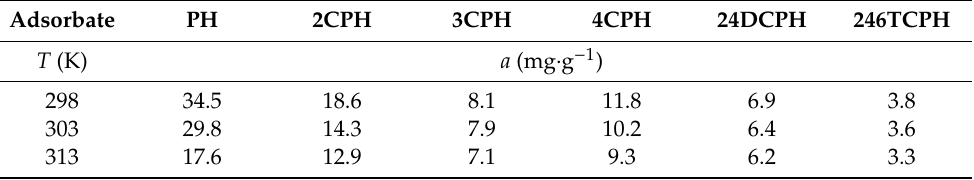
Table 8. The number of adsorbate milligrams adsorbed per unit mass of adsorbent for